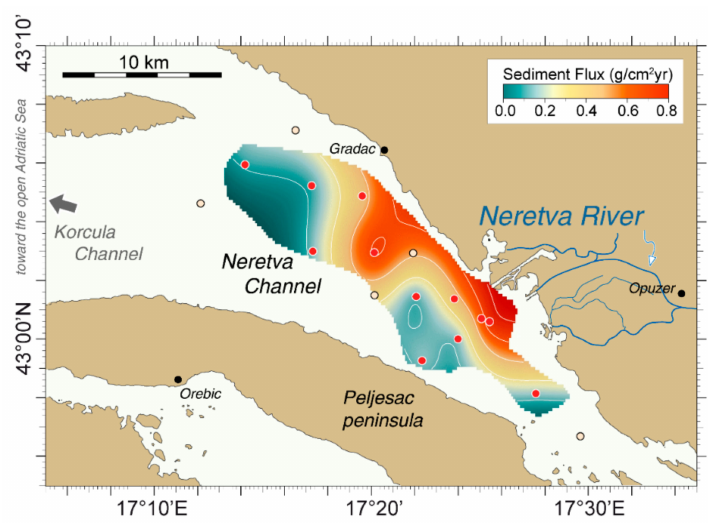
Figure 7. Areal distribution of sediment flux (g / cm 2 yr) in surficial sediment of the Neretva